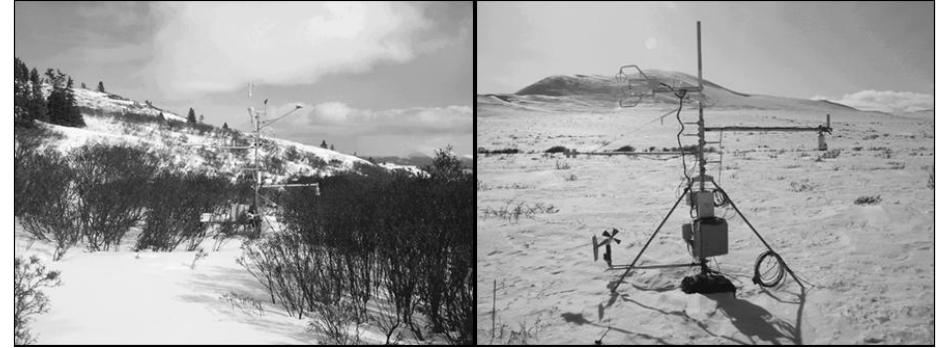
Fig. 2. Automatic weather stations at the valley site (left) and the plateau site (right). Both photographs were taken on 18 April 2004.